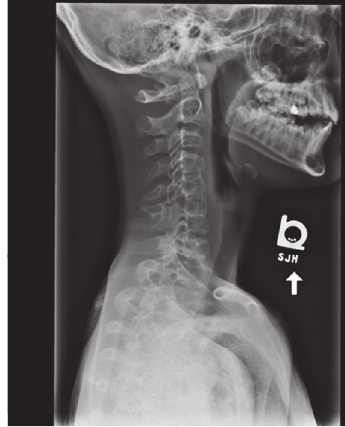
Figure 1: Chest X-ray revealing right lung agenesis and dextrocar- dia.